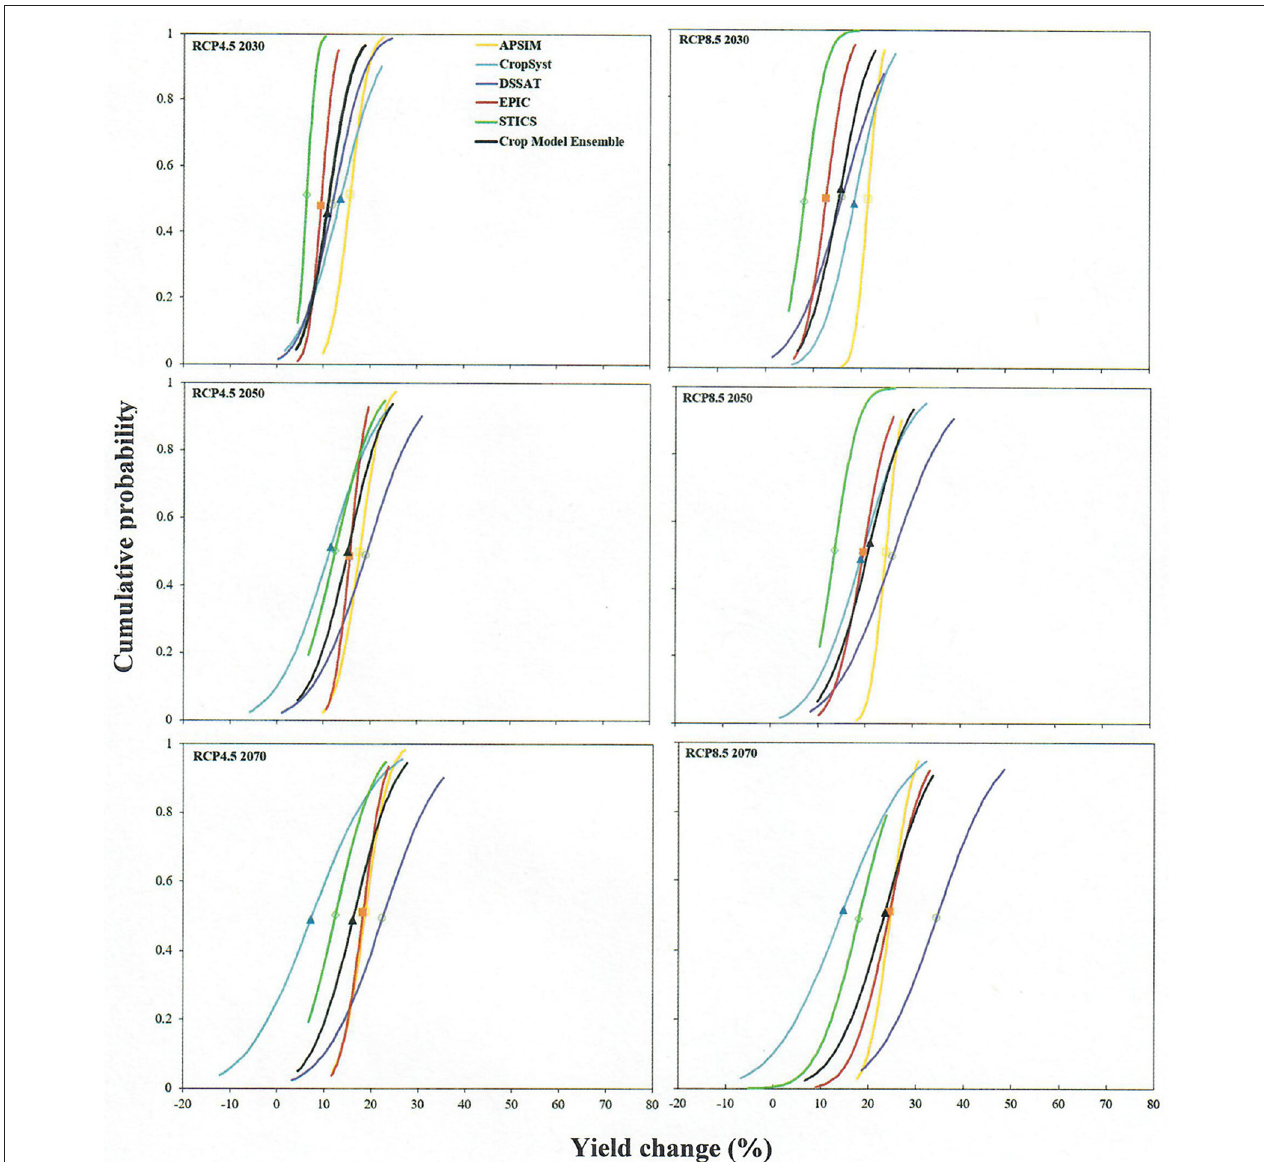
FIGURE 3 | Cumulative probability distribution for simulated winter wheat yield changes during three 31-year time periods, centered on 2030, 2050, and 2070, relative to the baseline period (1979–2010) under two representative concentration pathways (RCP4.5 and 8.5) and five crop models with ensembles of crop models at an irrigated site, Moses Lake, WA. Symbols on curves are at the curve’s inflection point and represent the most probable yield